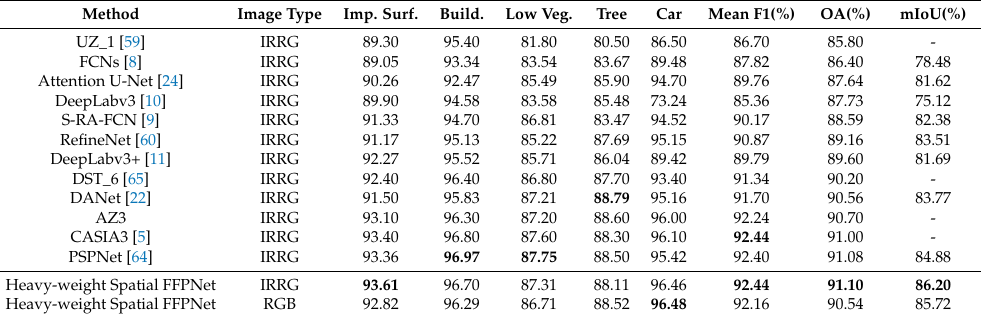
Table 7. Experimental results on the Potsdam dataset; the values in bold are the